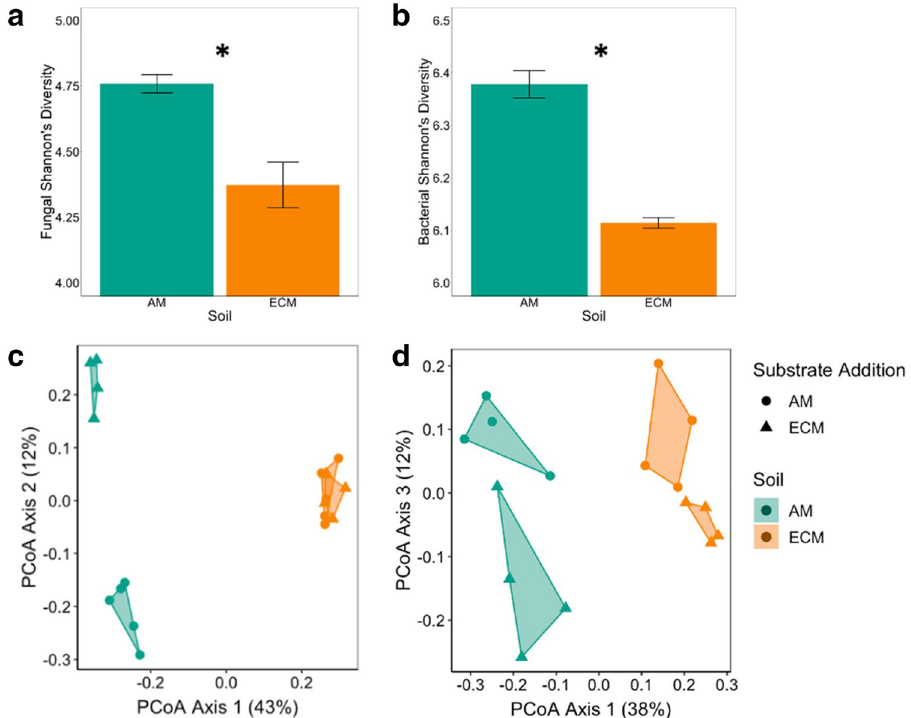
Figure 2. Variation in microbial diversity and composition between soils. Bar chart depicting fungal ( a ) and bacterial ( b ) Shannon diversity index (mean, standard error) in AM and ECM soils prior to incubation. Asterisks denote differences between soils at p < 0.05. Principal Coordinate Analysis showing variation in 13